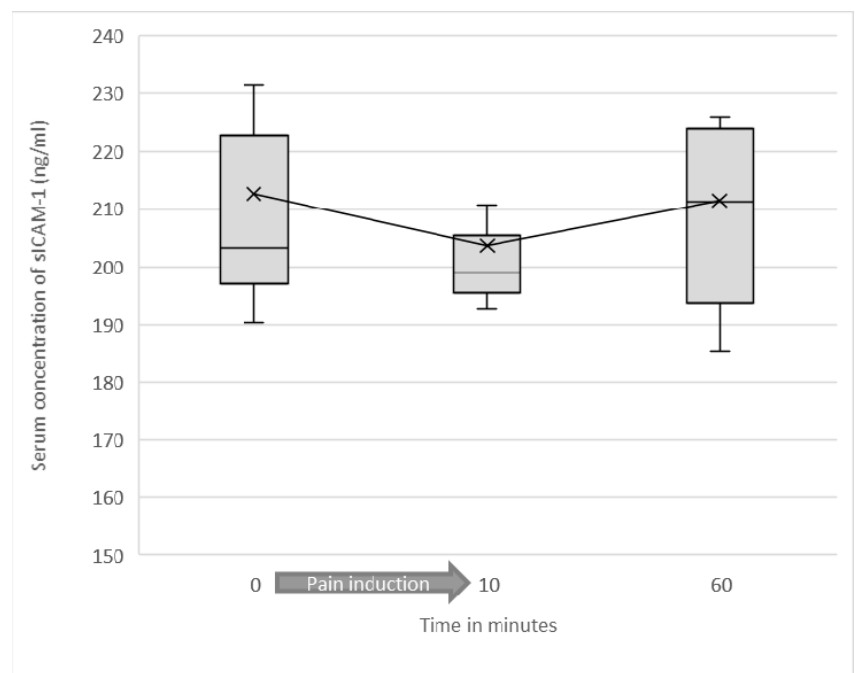
Figure 5. Soluble ICAM-1 serum concentrations as a function of test duration in cold pain group are shown as a box plot diagram. Outliers are not shown.